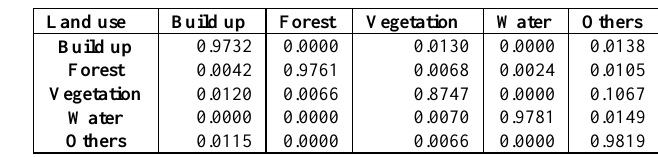
Table 7. Markov transition probability matrix (2015-2025) The resultant map of CA-Markov model predictions (Table 7, Figure 11) shows that build up area would be increased Figure 11: Land use (Hybrid) 2015